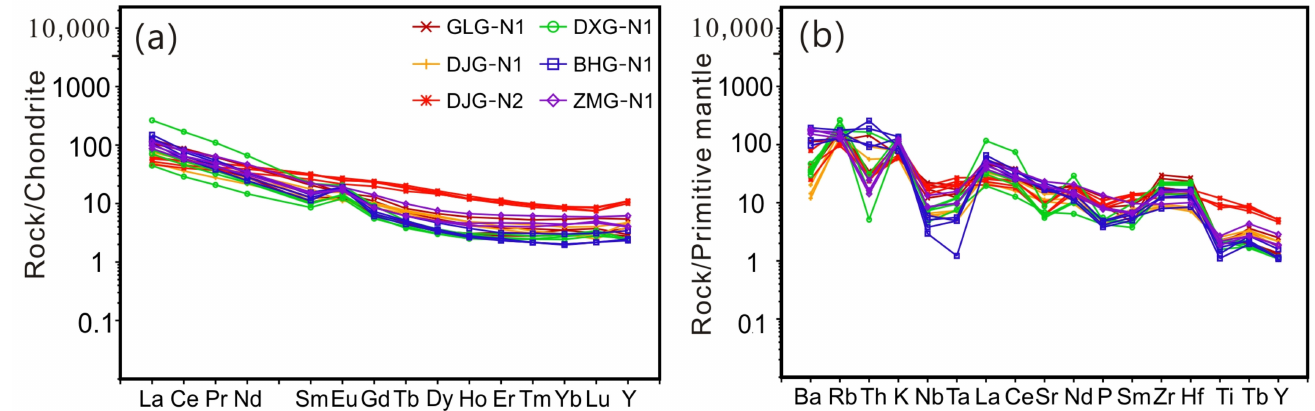
Figure 4. Chondrite-normalized REE pattern ( a ) and primitive mantle (PM) normalized spider diagram ( b ) for the TTG gneisses and diorites in the Liuhe deposits. Primitive mantle and chondrite values are from McDonough and Sun (1995) [40] and Sun and McDonough (1989) [39],